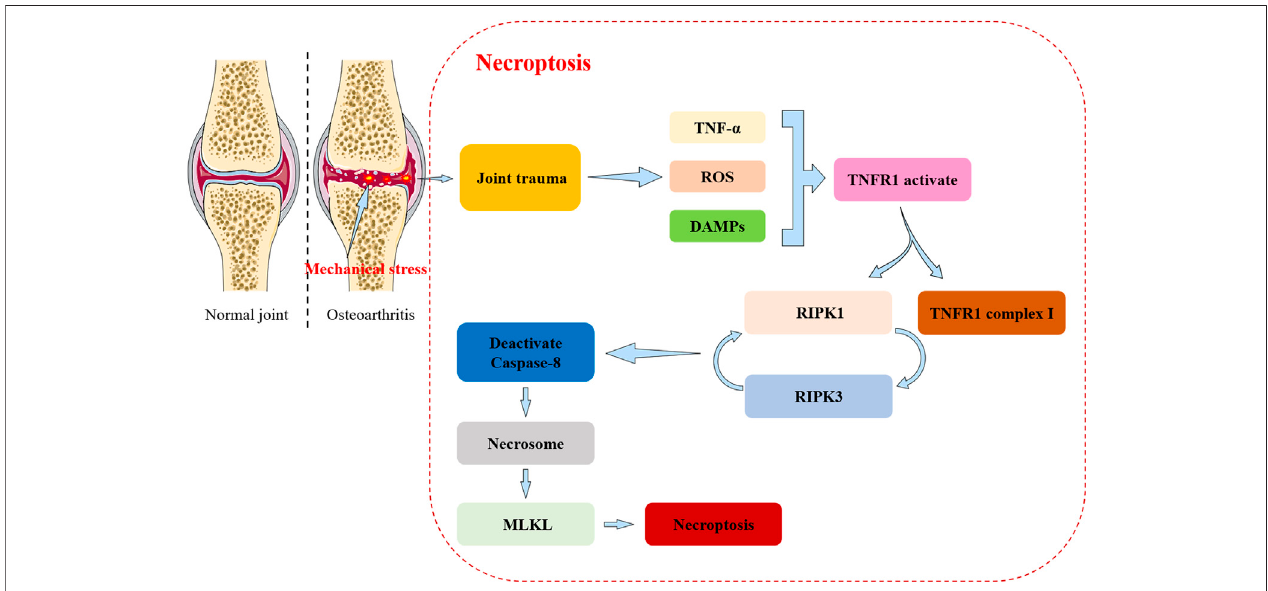
FIGURE 4 | The relationship between necroptosis and osteoarthritis (OA). Necroptosis: Joint trauma leads to the release of death-related triggers including tumor necrosis factor alpha (TNF- α ), reactive oxygen/nitrogen species (ROS/RNS), and damage associated molecular patterns (DAMPs). These factors subsequently lead to TNF receptor 1(TNFR1) activation, forming theTNFR1complexIand thereceptor interacting protein kinase1(RIPK1). RIPK1and RIPK3interacttoactivate caspase-8. When caspase8 is inactivated it leads to the appearance of necrosomes which cause the recruitment and phosphorylation of mixed-lineage kinase domain-like protein (MLKL), ultimately leading to disruption of membrane integrity. This leads to the formation of necroptosis.